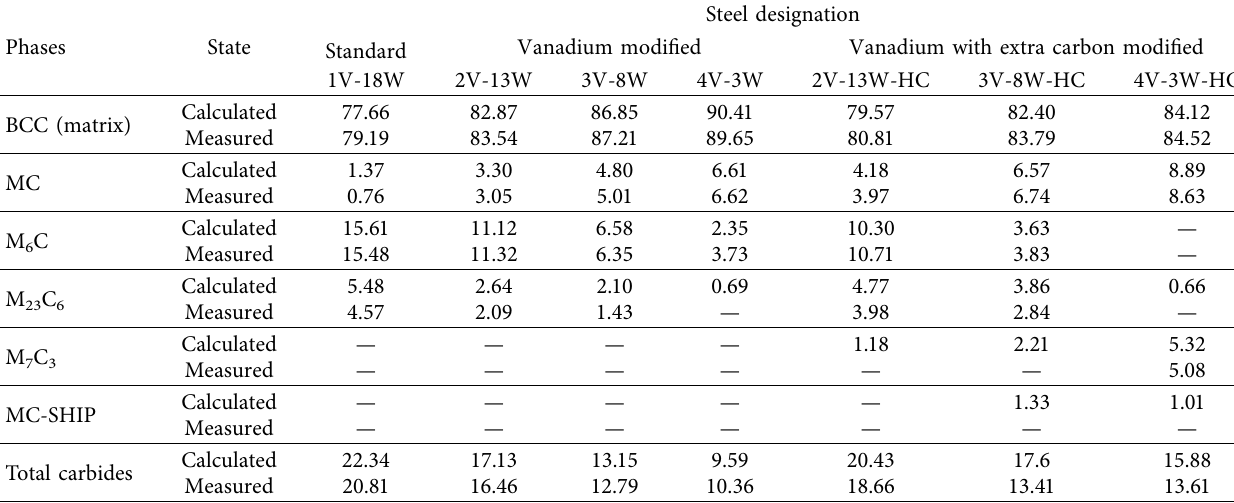
Table 2: Amount of the phase in the volume percent in T1 high-speed tool steel and its variant (as solidifed).